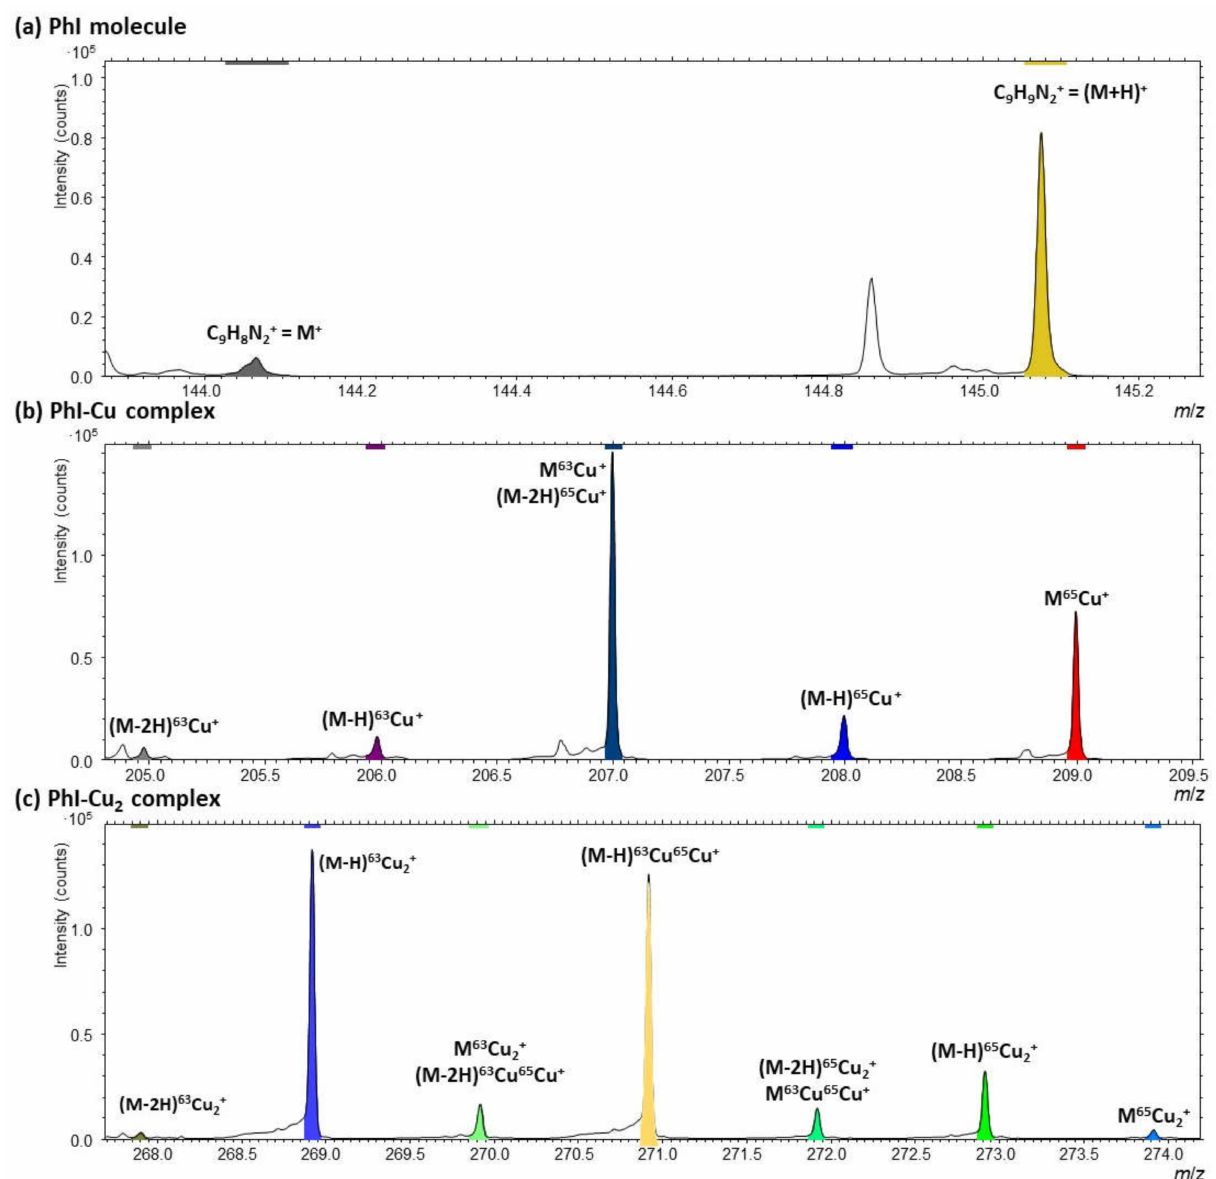
Figure 6. Positive ion ToF-SIMS spectra related to ( a ) the parent ion, ( b ) PhI-Cu organometallic complexes, and ( c ) PhI-Cu 2 organometallic complexes, which were formed on the 2PhI-treated